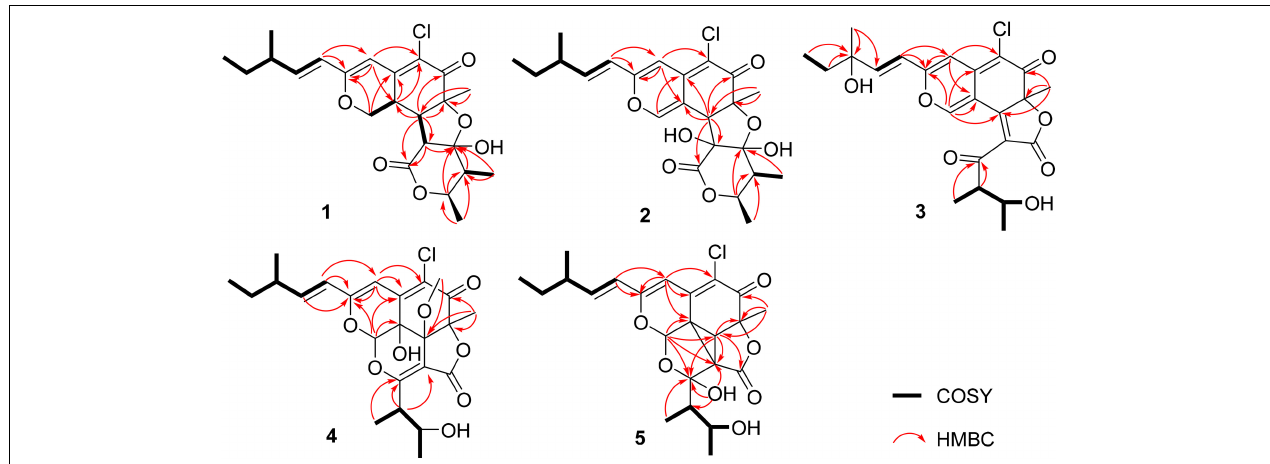
FIGURE 2 | Key 1 H– 1 H COSY and HMBC correlations of